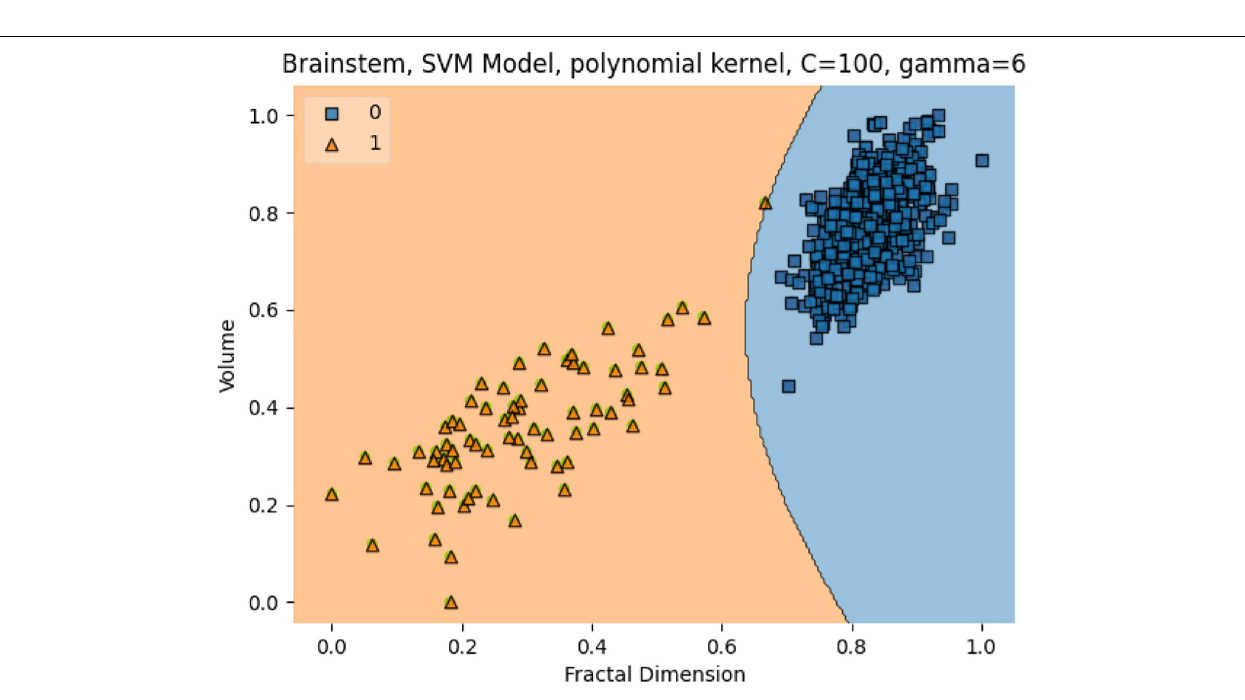
Frontiers in Aging Neuroscience |